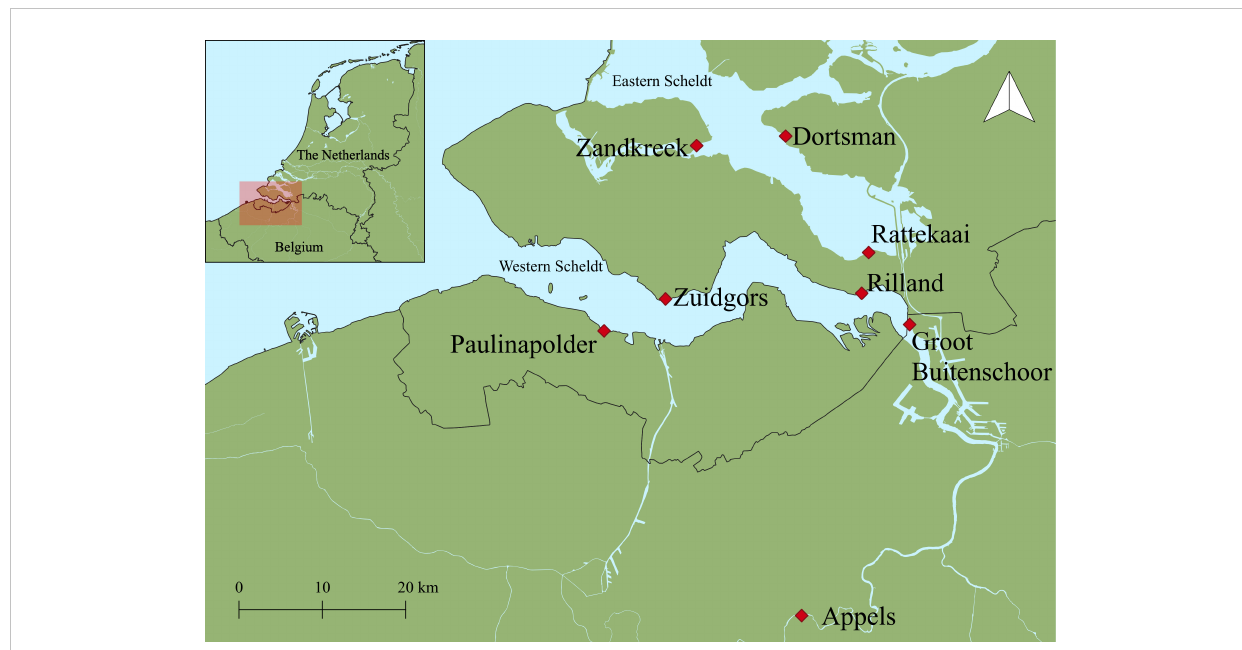
FIGURE 1 Map of sampling locations indicated with red diamonds. In the Western Scheldt: Appels (AP) in the freshwater, Groot Buitenschoor (GBS) and Rilland (RL) in the brackish, and Zuidgors (ZG) and Paulinapolder (PP) in the marine part. In the Eastern Scheldt: Rattekaai (RK), Dortsman (DT) and Zandkreek (ZK). Coordinates are in Appendix